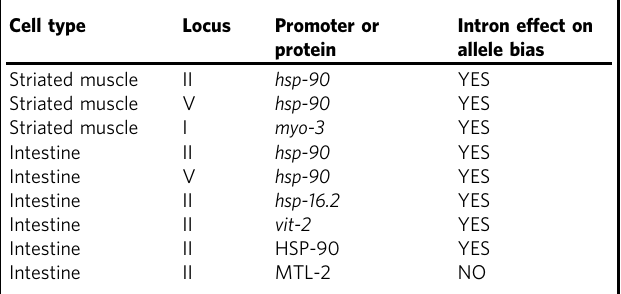
Table 1 Effects of introns on stochastic allele bias in muscle